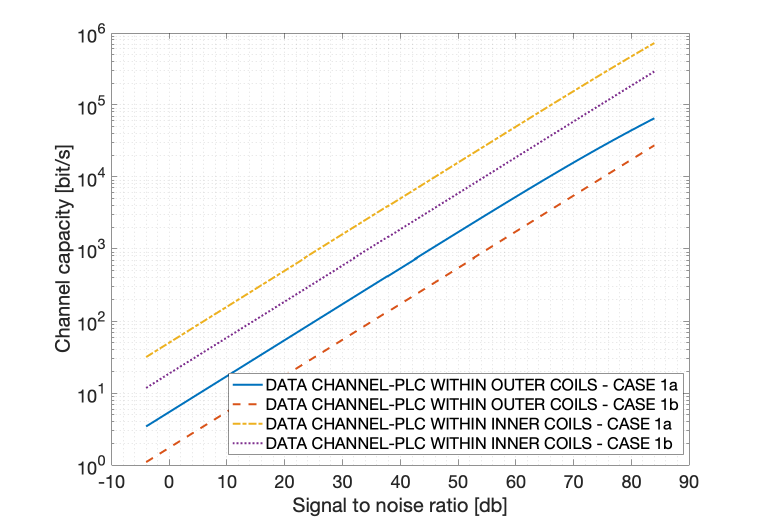
Figure 17. Channel capacity comparison, Case Study